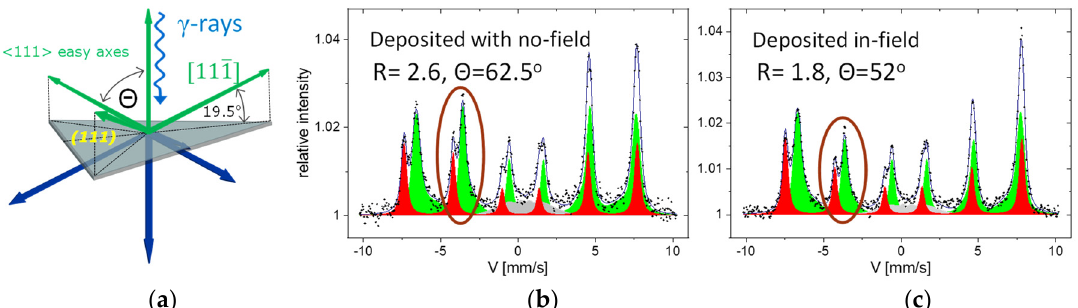
Figure 4. ( a ) Configuration of the easy magnetization axes for the (111)-oriented magnetite films. γ -ray illumination direction is indicated in the ex situ CEMS experiments. ( b , c ) CEMS spectra for the 10 nm Fe 3 O 4 (111) films on MgO(111) deposited with no-field and in-field, respectively.